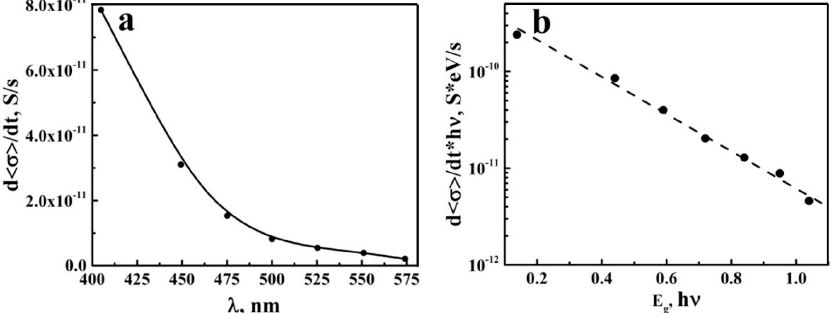
Figure 6. ( a ) the dependence of E pt · d (cid:104) σ (cid:105) / dt on the wavelength; ( b ) the Urbach plot for the examined segment of aTNTA. The points are experimental data, the curves are given as guides for the eye.